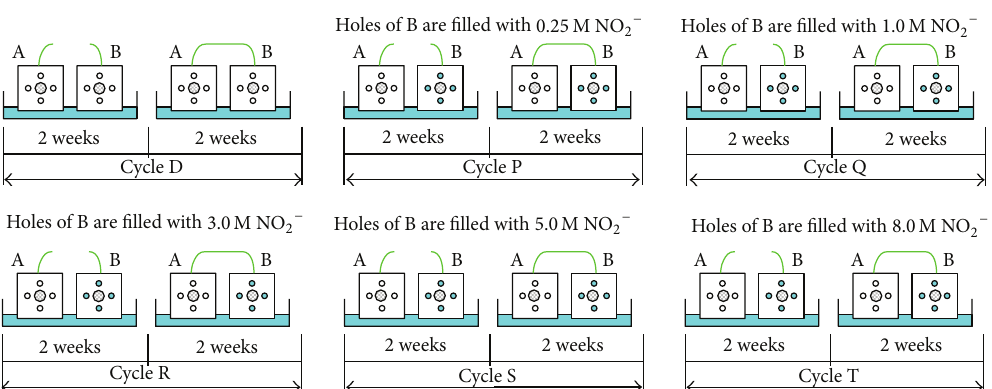
Figure 2: Experimental process and cycle types in this